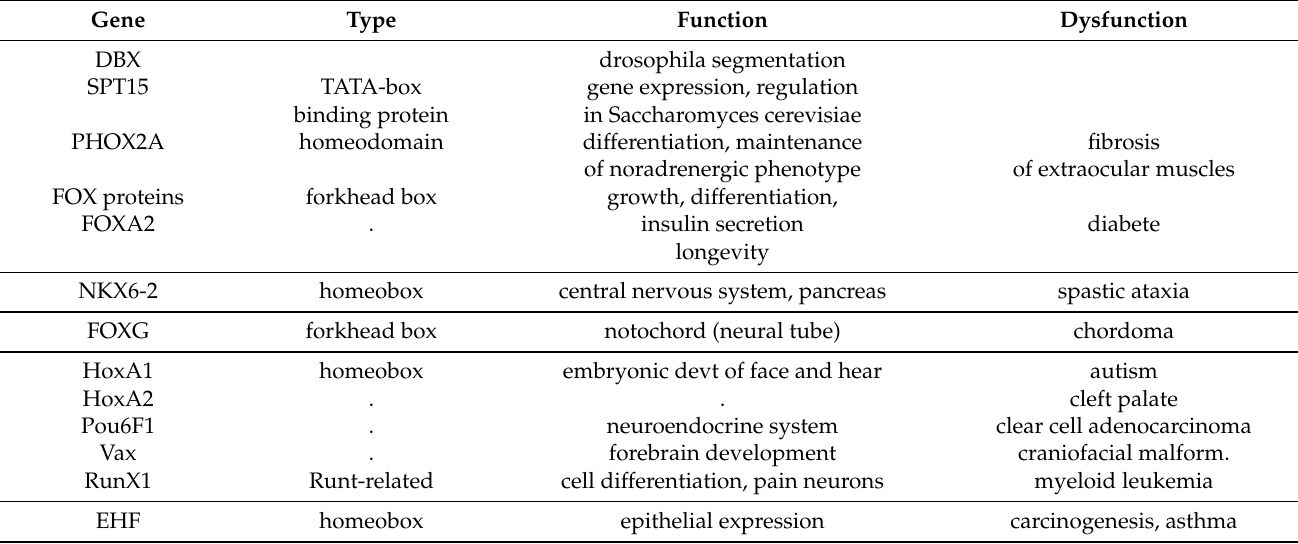
Table 3. A short account of the function or dysfunction (through mutations or isoforms) of genes associated with transcription factors and sections in Table